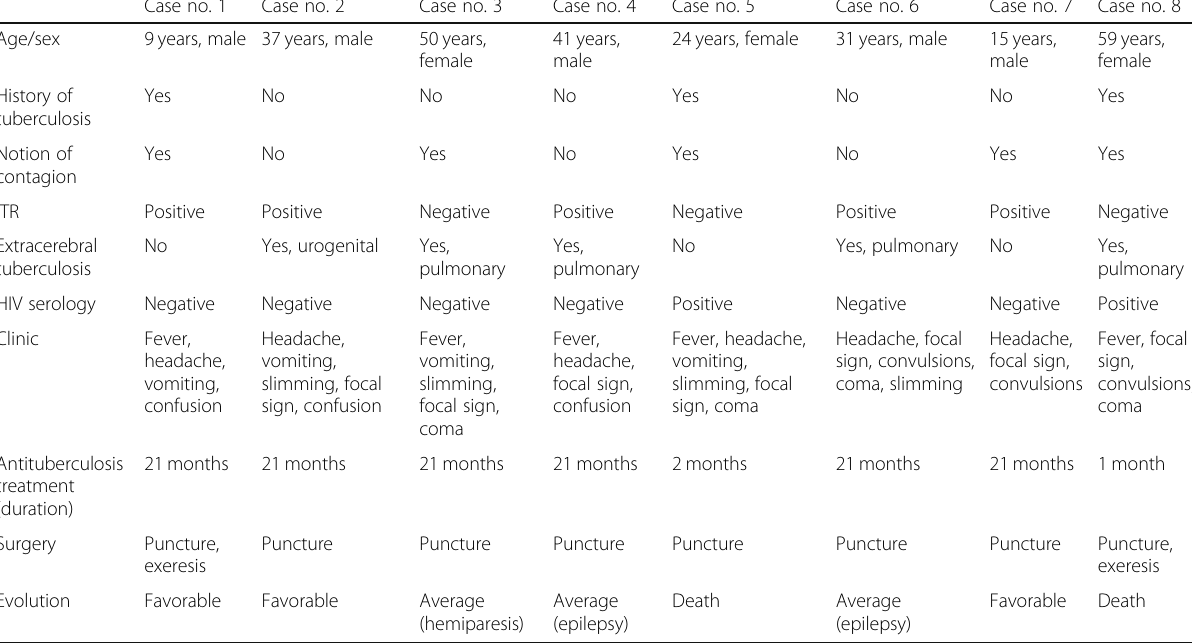
Table 1 General patients ’